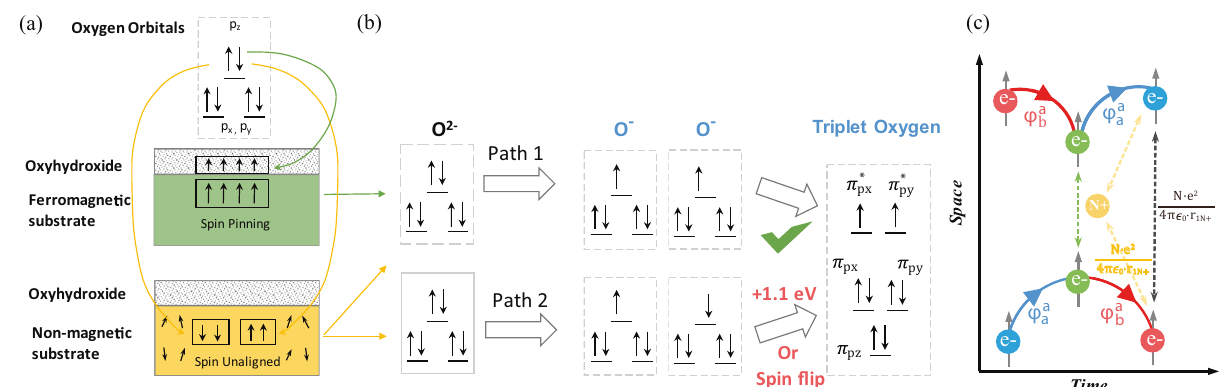
Fig. 3 Spin pinning effect for triplet oxygen evolution on the oxyhydroxide. a The spin-electron transfer from singlet oxygen (OH − , H 2 O) to Co 3 − x Fe x O 4 / Co(Fe)O x H y with and without spin pinning effect. b The triplet oxygen production by two oxygen radicals in parallel/opposite spin alignments. c The QSEI mechanism in a space – time Feynman diagrams. Two electrons with the same spin approach, in time from the left side, to avoid the increase of the Coulomb repulsions; the electrons exchange their orbitals (momentum) to effectively keep them apart. φ is the wavefunction of the orbitals (momentum) of spin electrons. The electronic repulsion between spin electrons is given as e 2 and electron – nuclei Coulomb attraction is given as N (cid:4) e 2 . 68 4 π ϵ 0 (cid:3) r 12 4 π ϵ 0 (cid:3) r 1 N þ